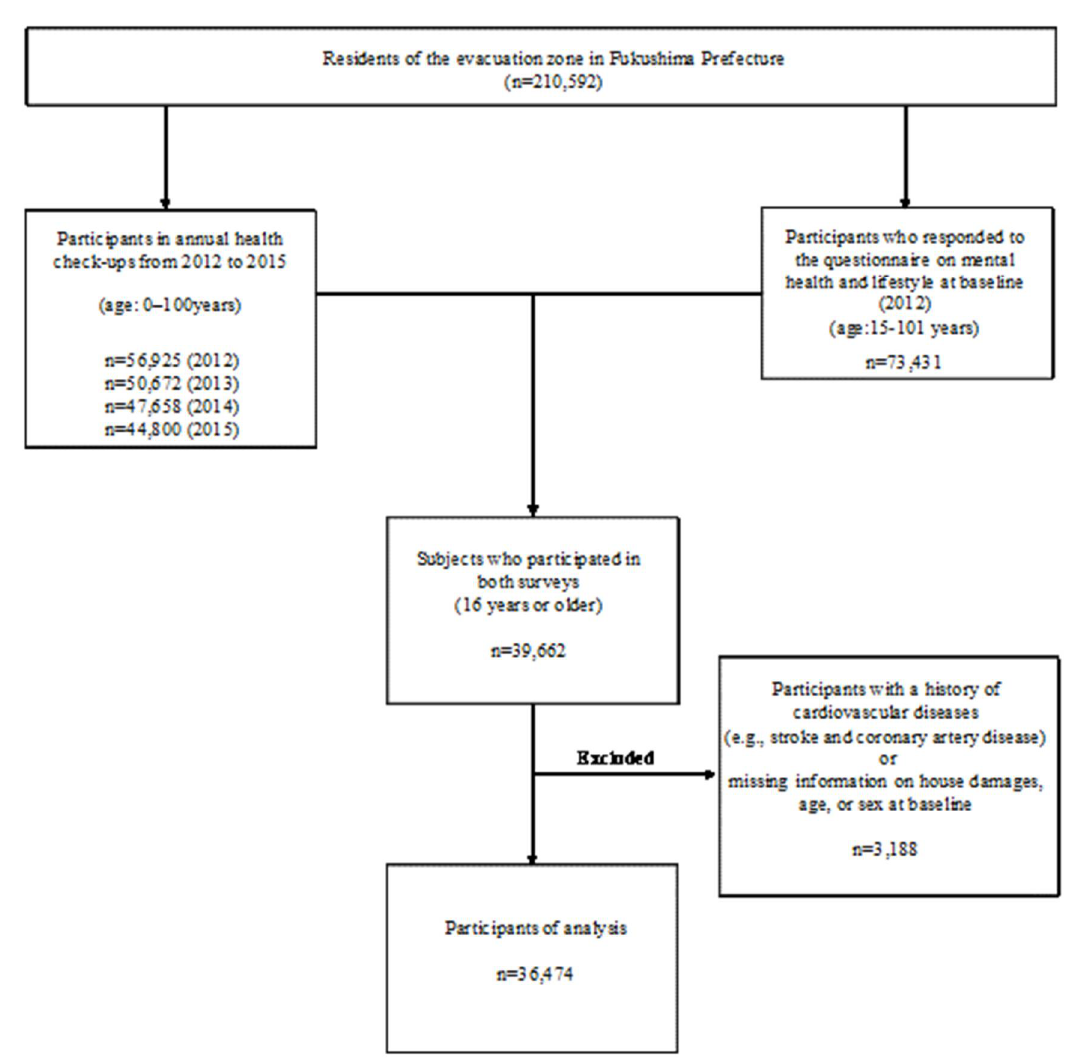
Figure 1. Flow chart of study participant selection.